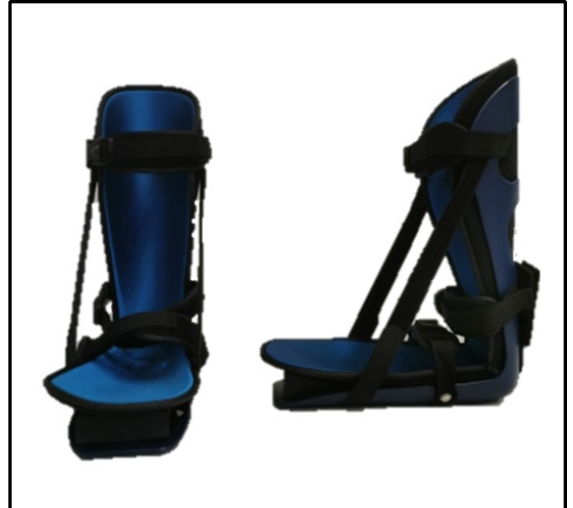
Figure 1. The orthopedic boots used in the